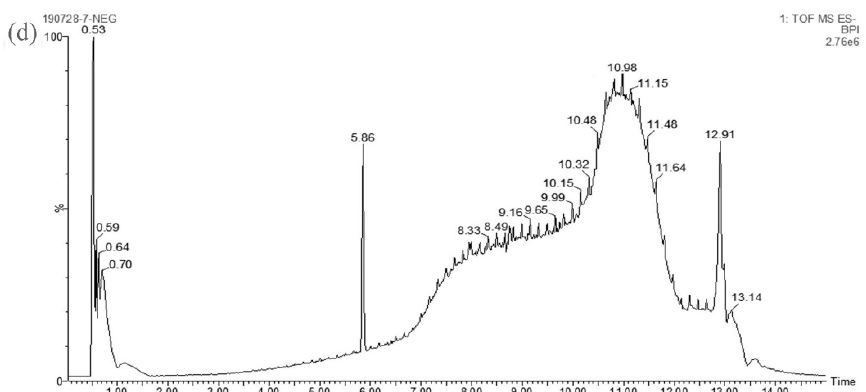
Figure 5. Ultra-high-performance liquid chromatography-tandem time-of-flight mass spectrometer (UPLC-HRMS) profile of C. rotundus aqueous extracts. ( a , c ) represent the aqueous extracts in positive and negative ionization mode, respectively. ( b , d ) represent the modified seawater in positive and negative ionization mode, respectively.